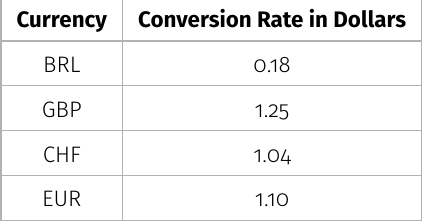
was not available, it was considered to be zero.